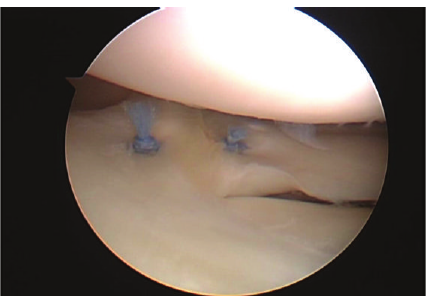
Figure 4: Arthroscopic views of the right knee. Meniscocapsular separation was fixed by the FAST-FIX Meniscal Repair Suture